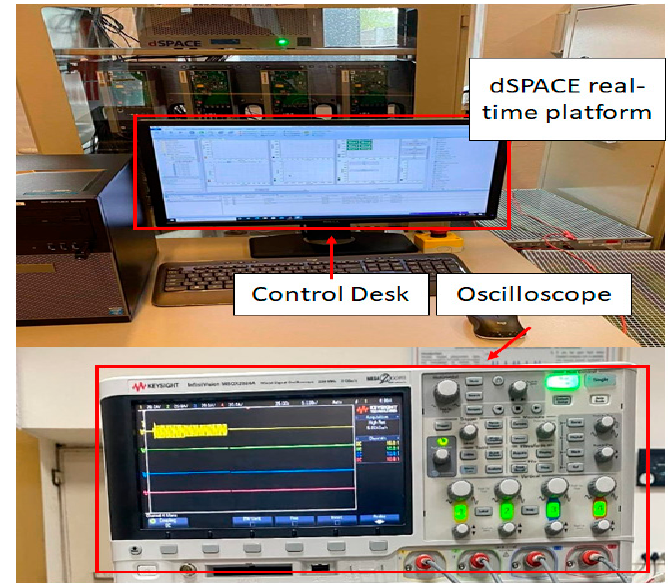
Figure 16. Hardware-in-loop experimental setup. Figures 17 and 18 show the hardware-in-loop (HIL) results under the transient load